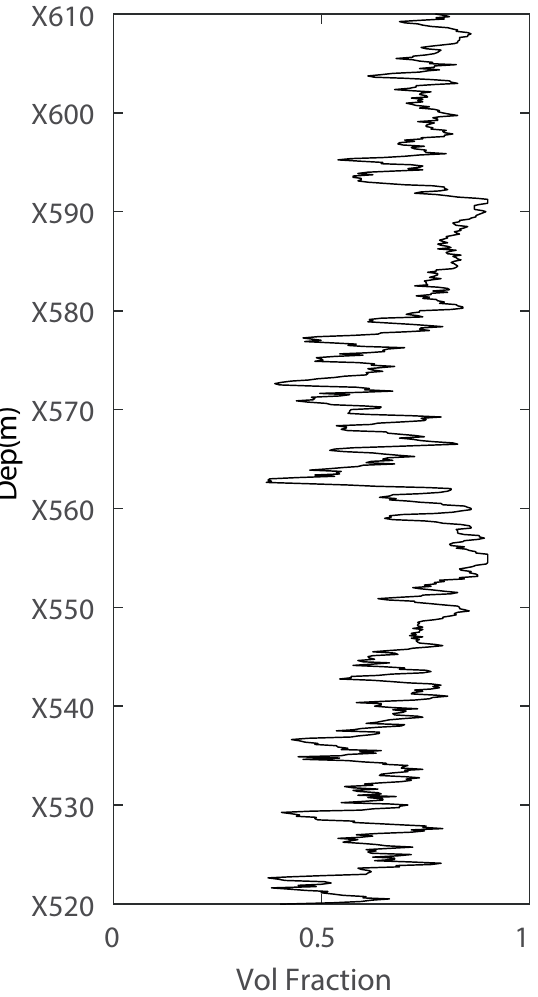
Figure 6. Volume fraction of layered clay with respect to the total clay